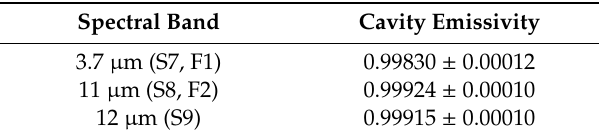
Table 2. Internal Blackbody (BB) emissivity as reported in [11]. Uncertainties are reported at a coverage factor, k =